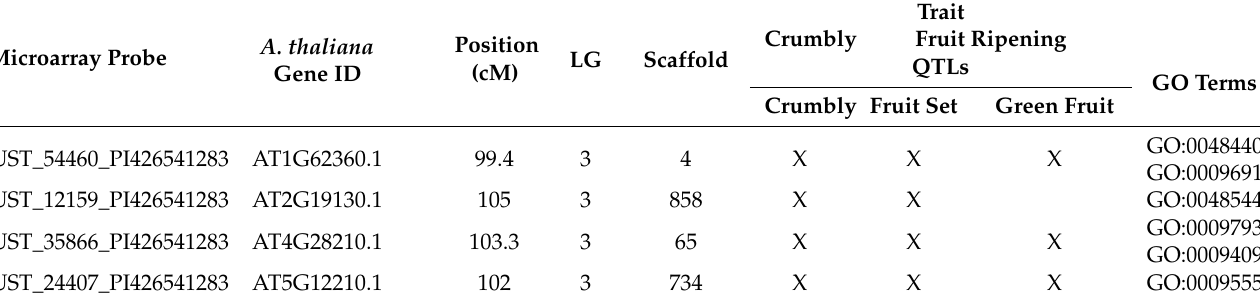
Table 3. List of crumbly microarray probes matching A. thaliana ortholog genes that map in overlapping QTL regions containing crumbly and fruit ripening traits at position in centimorgans (cM) on linkage group (LG) 3. For each probe, the matched A. thaliana ortholog gene and the gene ontology (GO) terms associated with it are presented, together with the gene scaffold were the Rubus idaeus equivalent gene is located. The five probes are listed in the same order as Figure 3. The QTLs containing scaffold regions matched by the microarray probes are marked with uppercase “X”.